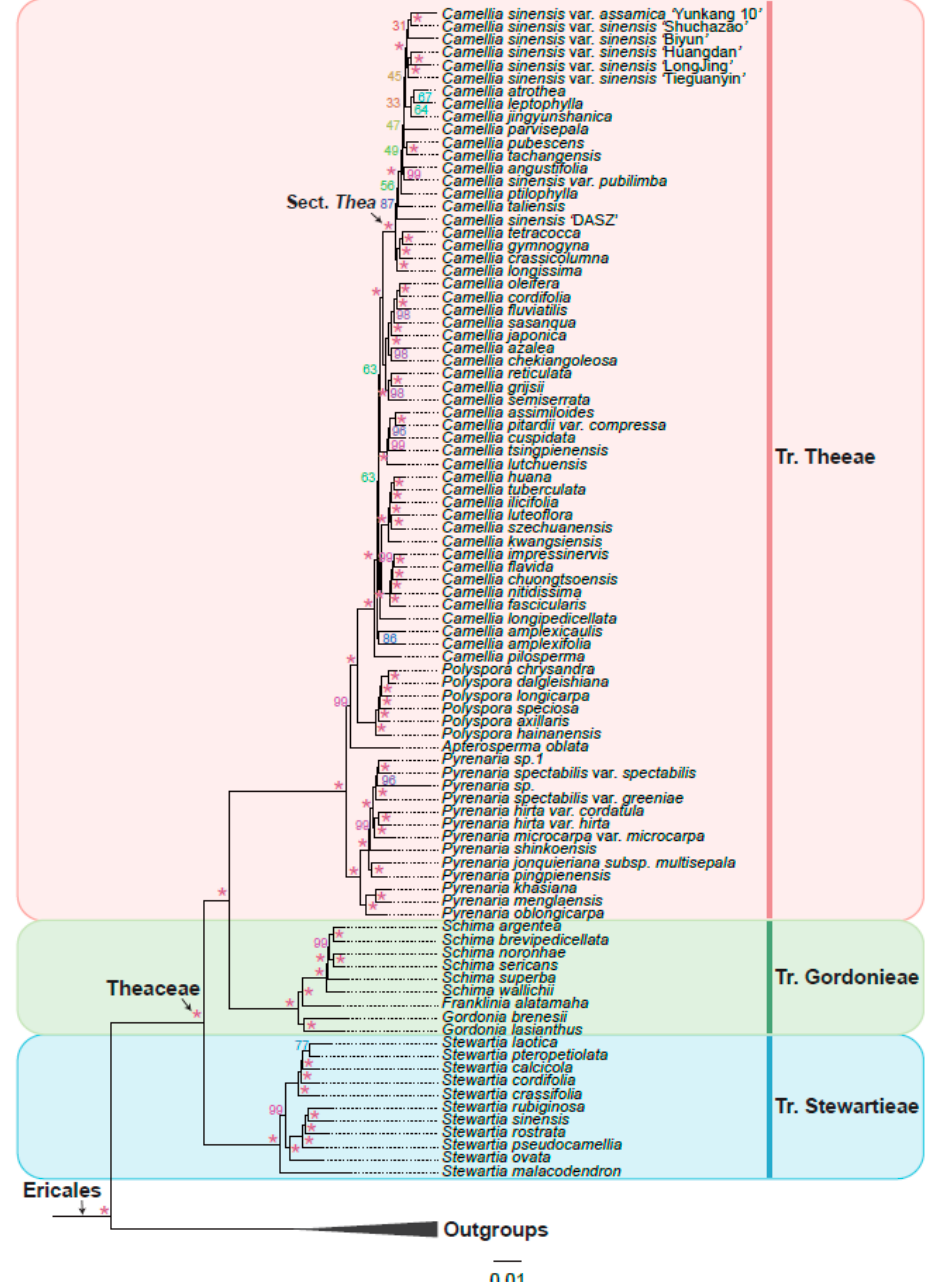
Figure 4. The maximum likelihood (ML) phylogenetic tree was inferred from a concatenated super- matrix of 253 low-copy nuclear genes. The ML tree was reconstructed using IQ-TREE with GTR+G model and 1000 bootstrap replicates. Asterisk indicates bootstrap support 100. The pink, green, and blue vertical line on the right indicate Tr. Theeae, Tr. Gordonieae, and Tr. Stewartieae, respectively. The outgroups collapsed into a black triangle.